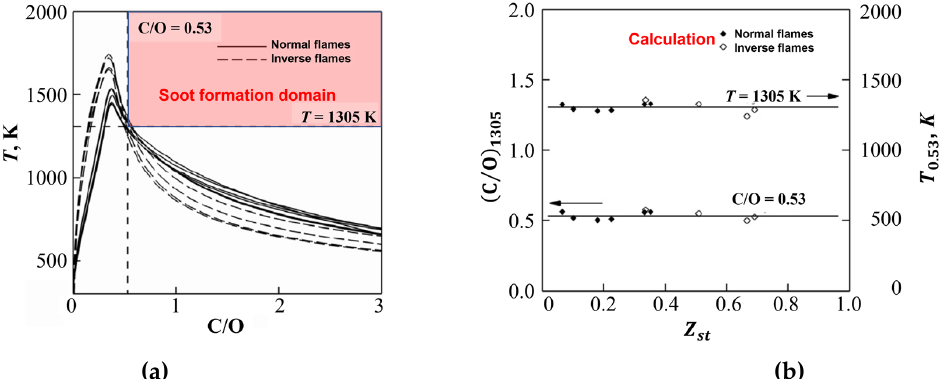
Figure 11. Calculated dependences of ( a ) temperature on the local atomic ratio C/O and ( b ) temperature T 0.53 and atomic ratio ( C / O ) on the stoichiometric mixture fraction Z st in normal and inverse flames in 2 s after ignition [24].